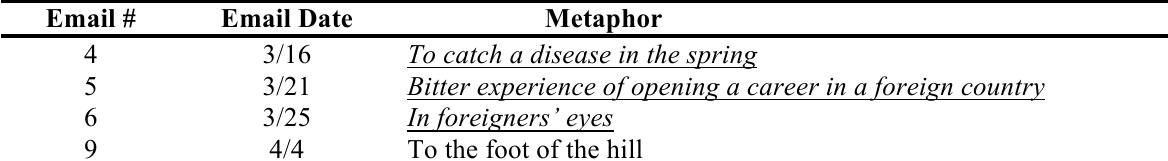
Metaphors produced by